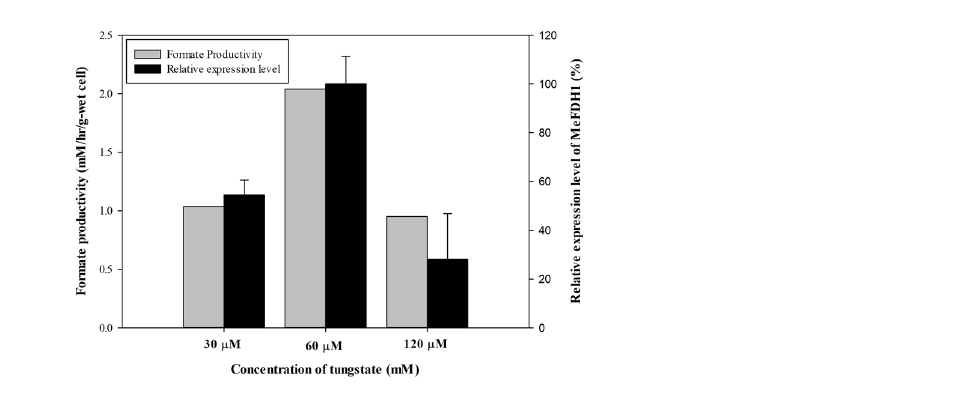
Figure 5. Relative expression level of MeFDH1 depending on cofactor (W) concentration and formate productivity in electrochemical